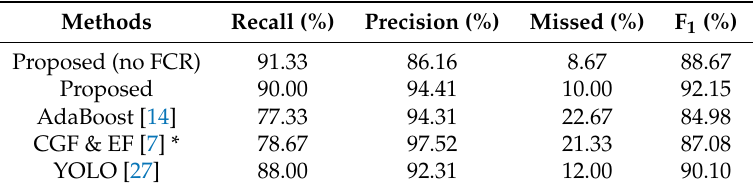
Table 5. A comparison of several tomato detection